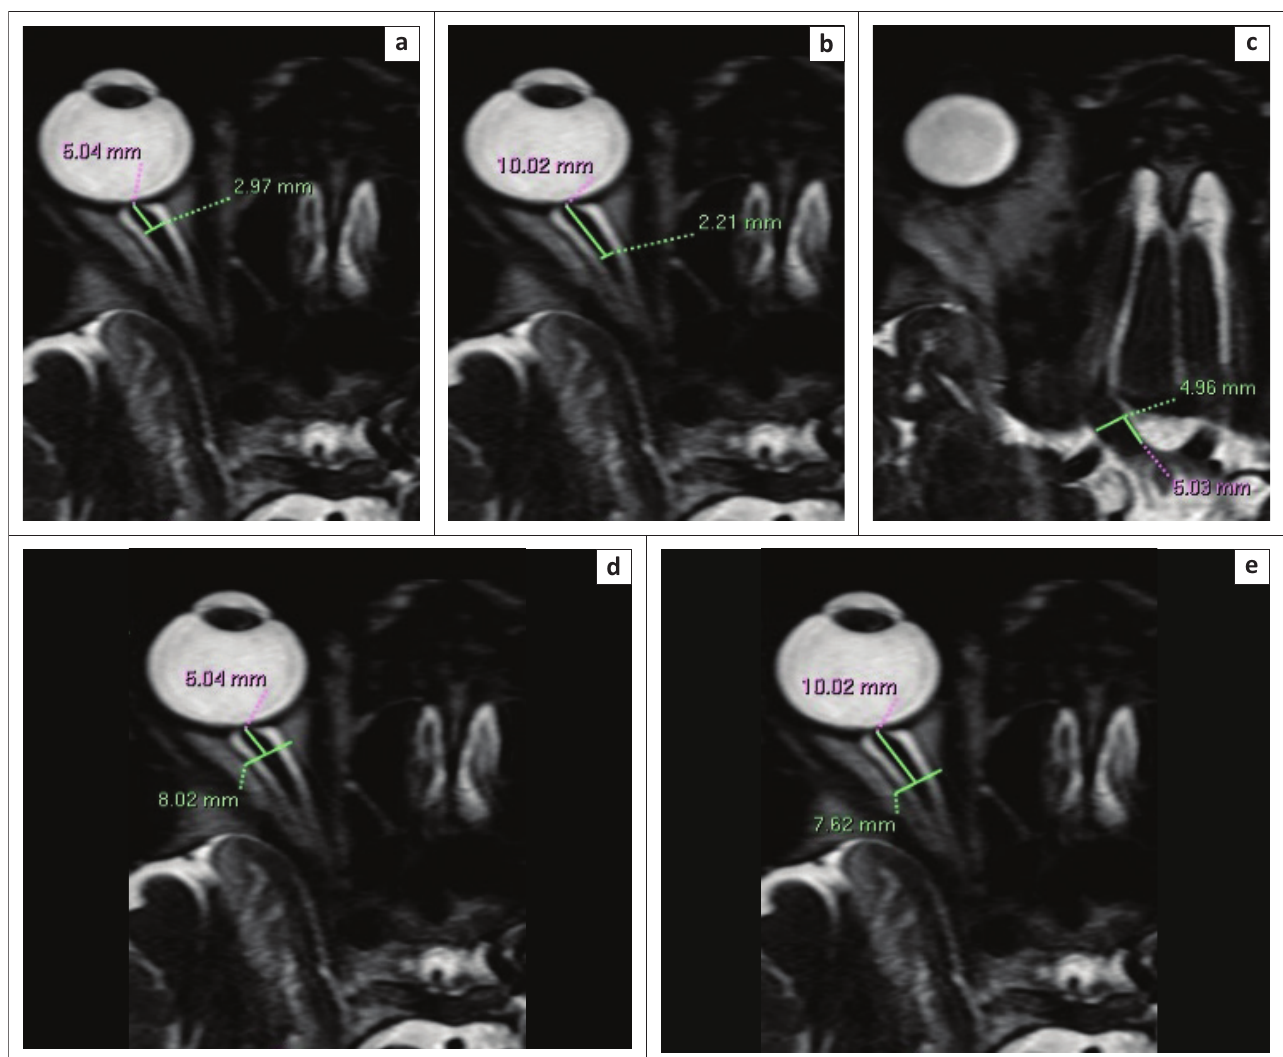
FIGURE 1: Axial T2W 3D magnetic resonance imaging of the right orbit demonstrating the measurement technique: (a and b) intraorbital optic nerve width 5 mm and 10 mm behind the globe, respectively; (c) intracranial optic nerve width and (d and e) optic nerve sheath width 5 mm and 10 mm behind the globe,